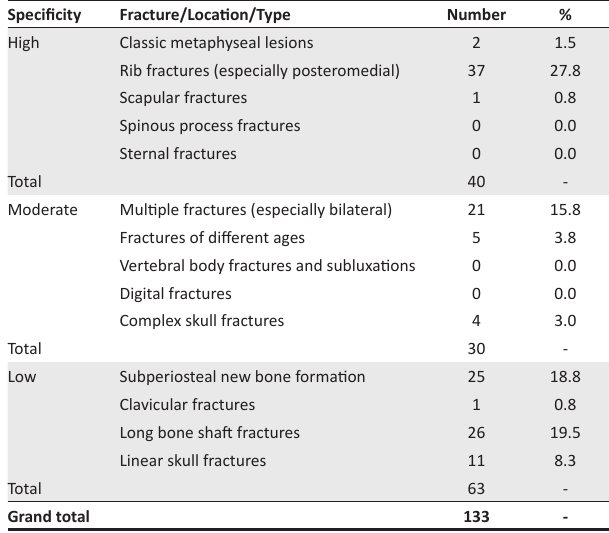
TABLE 3: Specificity of fracture locations and reader